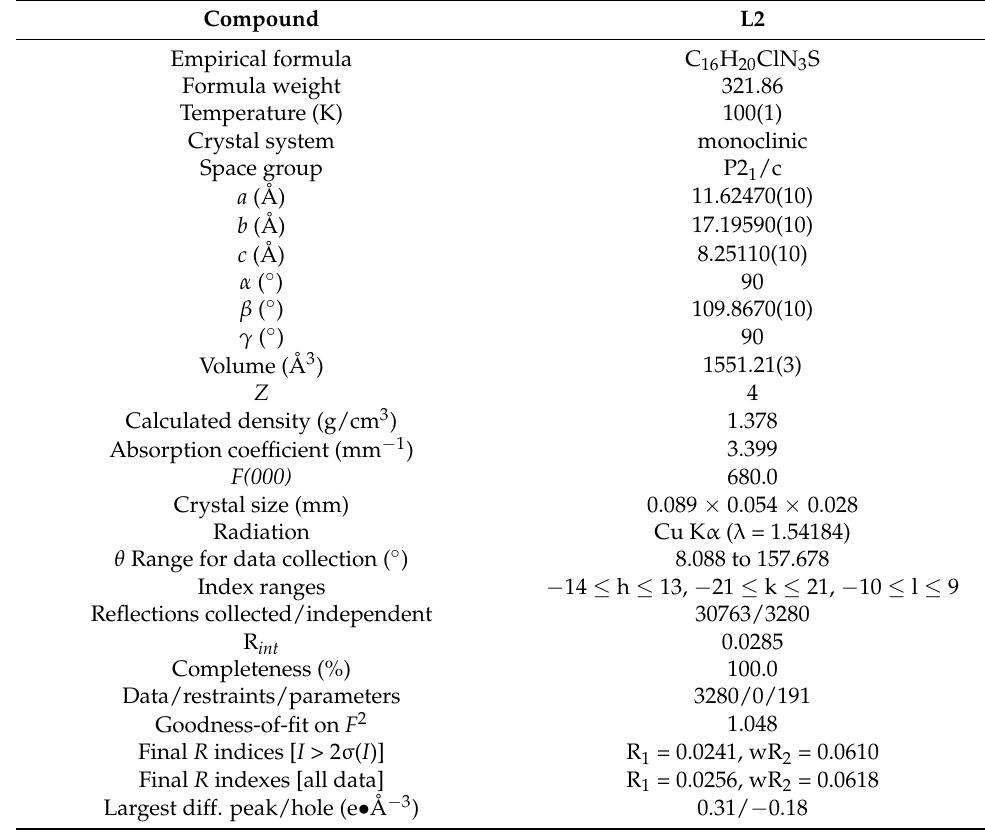
Table 7. X-ray diffraction data and structure refinement details for ligand